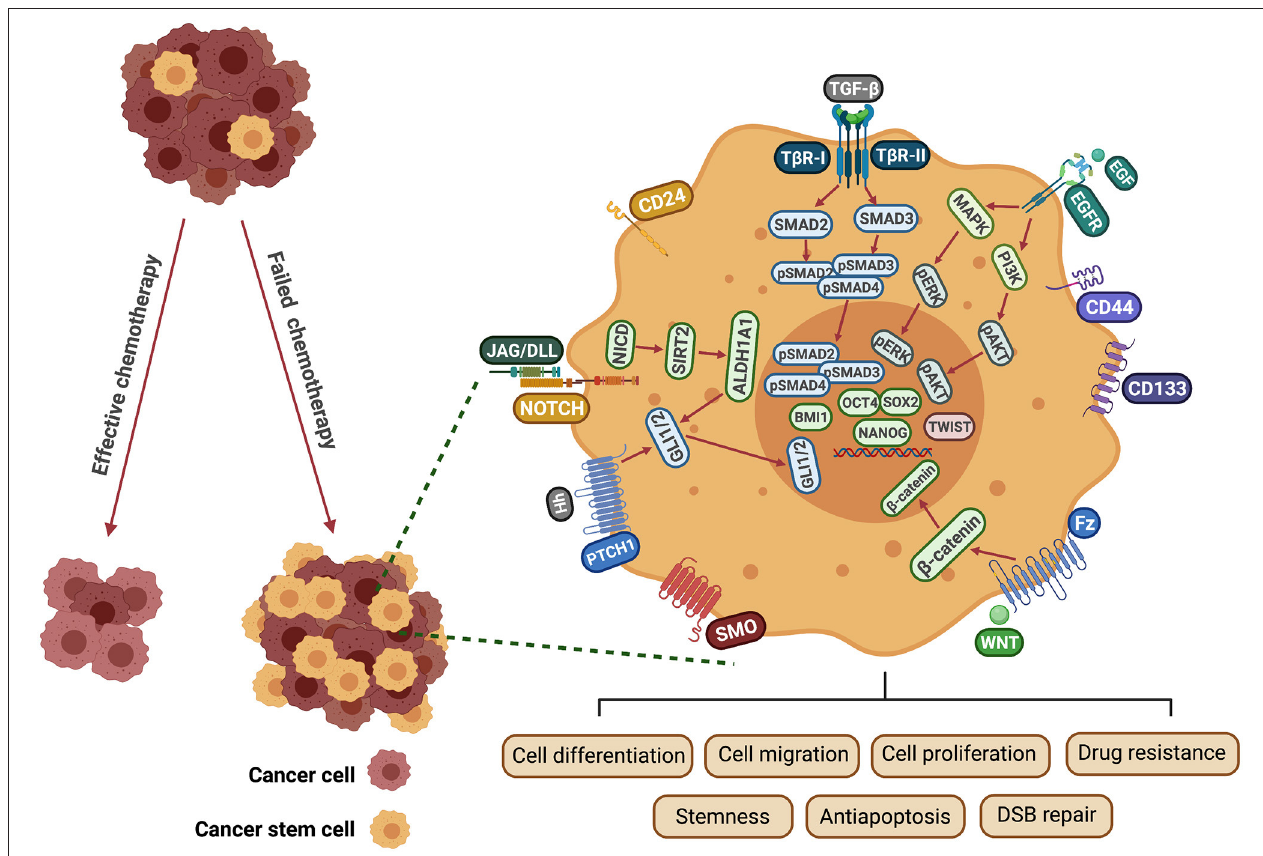
FIGURE 2 | Mechanisms involved in CSC-induced drug resistance in HNSCC. EGF binds to the EGFR receptor tyrosine kinase resulting in activation and autophosphorylation of the receptor. This activates RAS and PI3K, triggering major signaling cascades that include MEK/ERK and PI3K/AKT. NOTCH-activated NICD1, upregulates the SIRT2/ALDH1A pathway. Hedgehog ligands (Hh) bind to Patched receptors and derepress the G-protein-coupled receptor (GPCR) SMO. Hh targets ALDH + CSCs through GLI1 expression, which is regulated by ALDH1A1. WNT proteins bind to the Fz transmembrane receptor and the LRP 5/6 to form a functional complex. β -catenin then becomes uncoupled from the degradation complex and translocates to the nucleus to promote transcription of downstream targets. TGF- β is recognized by T β R1/2 resulting in the phosphorylation of SMAD 2/3 and formation of a SMAD 2/3/4 complex. These pathways are involved in regulating multiple biological functions of CSCs, including cell proliferation, migration, invasion, self-renewal and survival. EGF, epidermal growth factor; EGFR, epidermal growth factor receptor; Fz, frizzled; JAG, Jagged ligand; DLL, Delta-like ligand; DSB, double-strand break; NICD, intracellular domain of NOTCH protein; SMO, smoothened; MAPK, mitogen-activated protein kinase; PI3K, phosphoinositide 3-kinases; PATCH1, Protein patched homolog 1; TGF- β , transforming growth factor; T β R, transforming growth factor β receptor; ALDH1, Aldehyde dehydrogenase 1 family; BMI1, B lymphoma Mo-MLV insertion region 1 homolog; OCT4, Octamer-binding transcription factor 4; SOX2, Sex determining region Y-box 2; NANOG, Nanog homeobox.